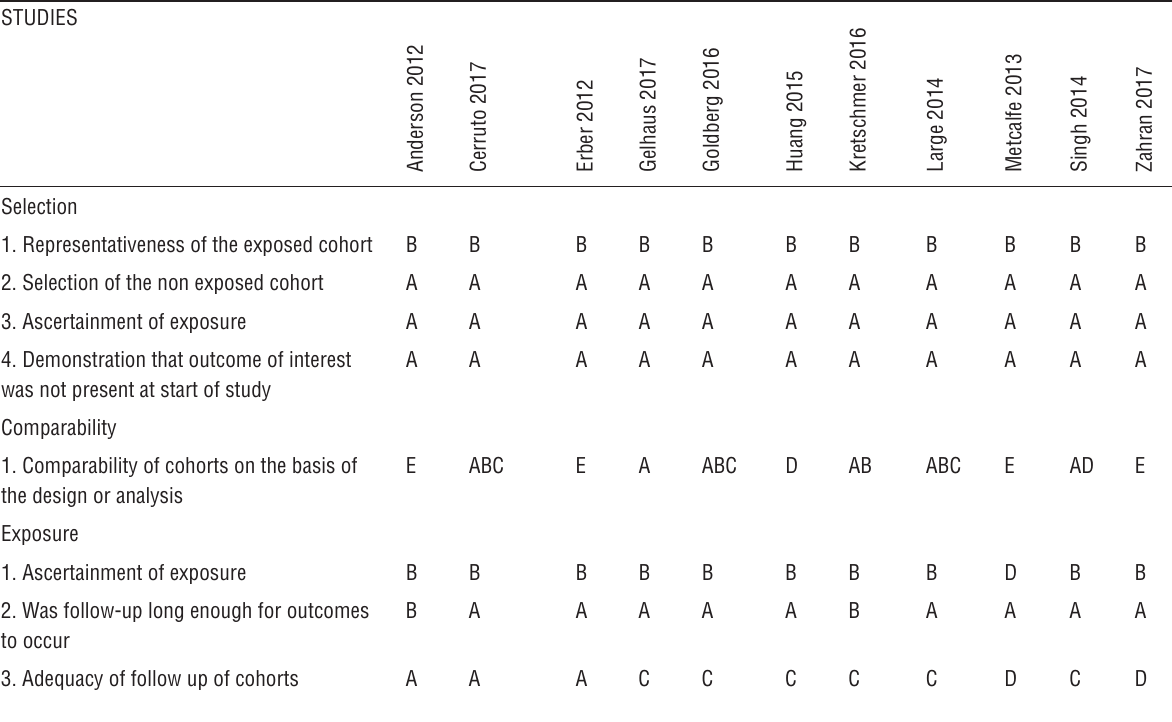
Table 2 - The Newcastle-Ottawa scale assessing risk of bias across the studies.